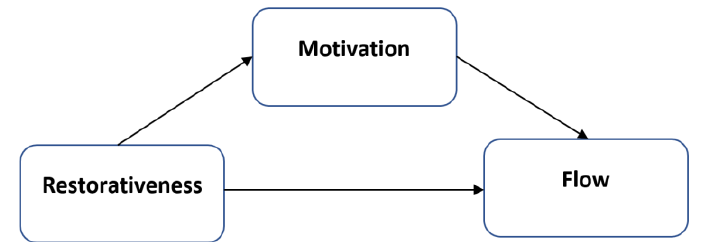
Figure 1. Conceptual mediational model.